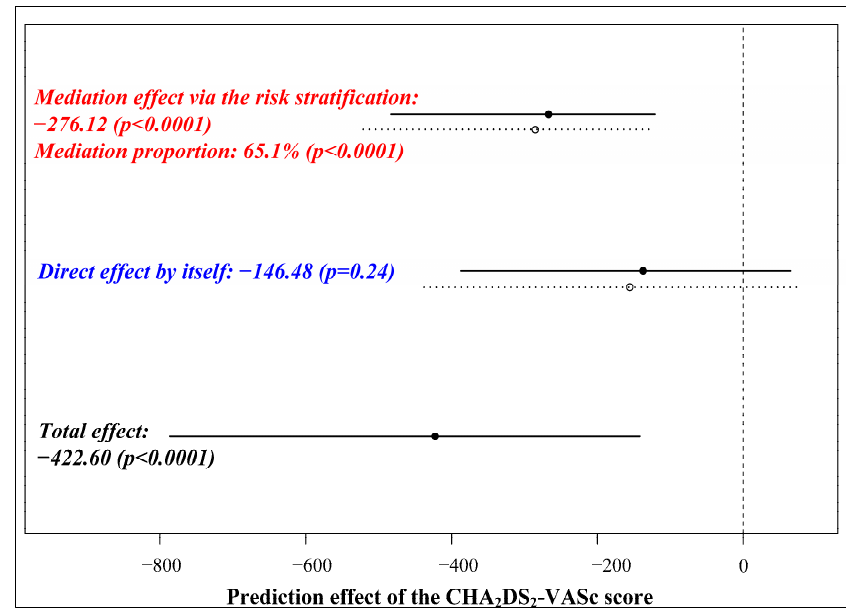
Figure 9. Mediation effect analysis of the CHA 2 DS 2 -VASc score.